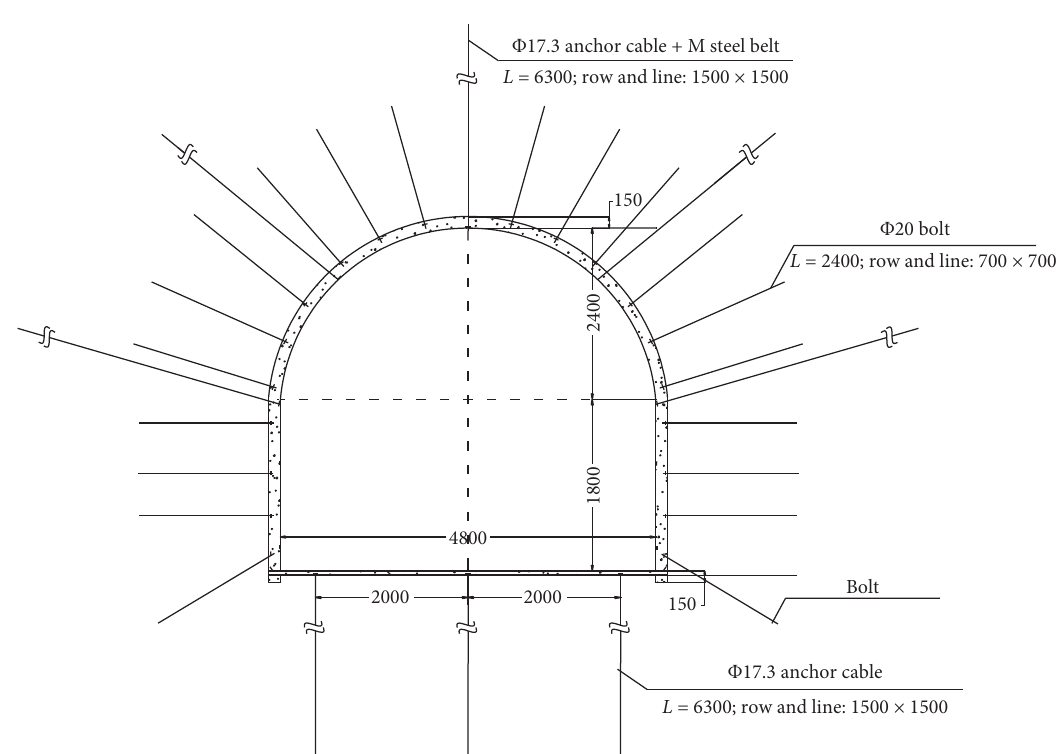
Figure 12: Original supporting scheme of 101 track roadway (unit: